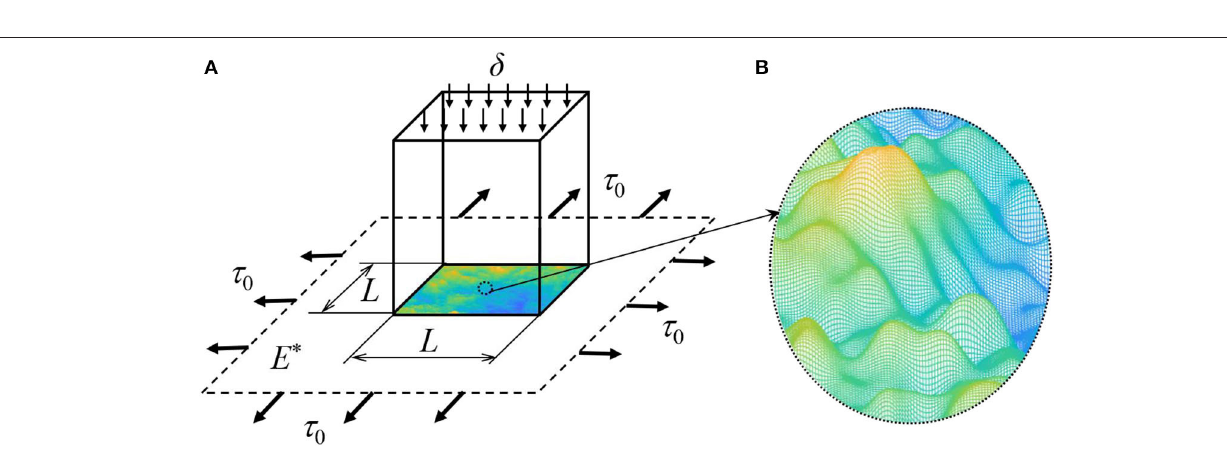
square flat-ended indenter with length L . Note that the highest point of rough surface is initially put on the surface of half